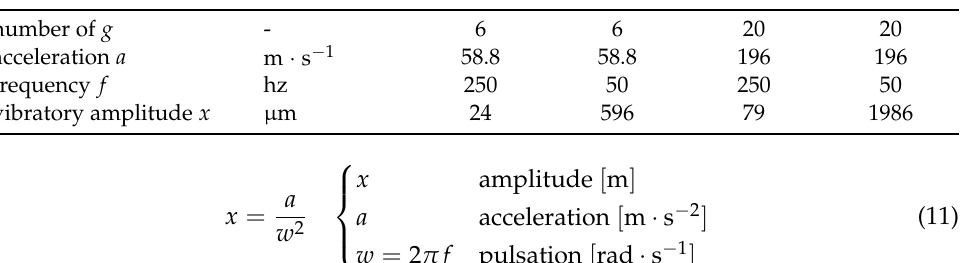
Table 4. Vibratory amplitudes for different acceleration and